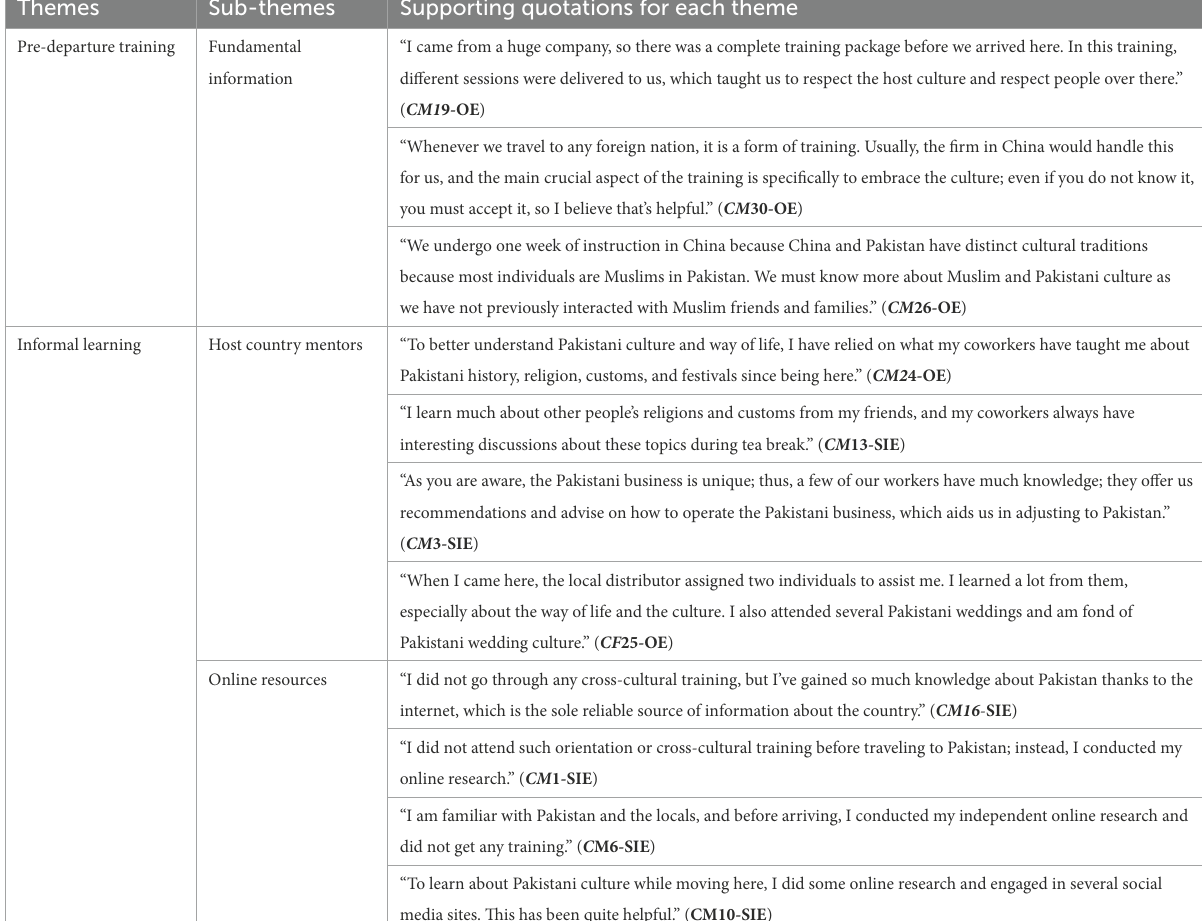
TABLE 5 Cross-cultural training themes and